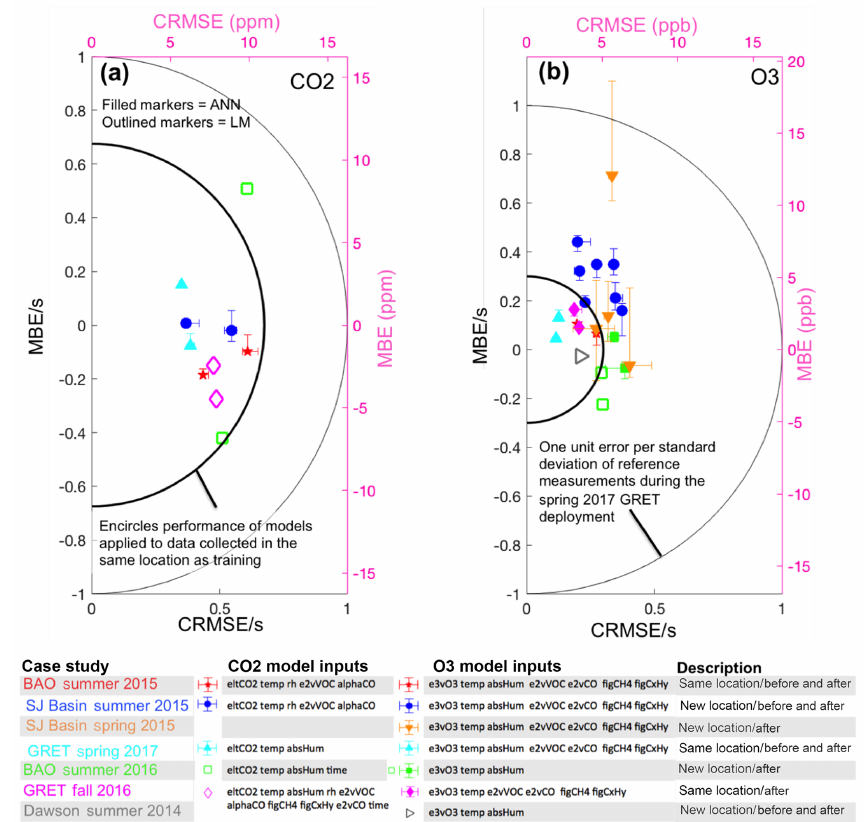
Figure 12. Target diagrams for (a) CO 2 and (b) O 3 calibration model performance for the best-performing model for each particular case when tested on data from a number of field deployments. Model input definitions: eltCO2 (ELT S-300 CO2 sensor), e2vCO (e2v MiCS-5525 sensor), e2vVOC (e2v MiCS-5521 sensor), e2vO3 (e2v MiCS-2611 sensor), figCH4 (Figaro TGS 2600 sensor), figCxHy (Figaro TGS 2602 sensor), alphaCO (Alphasense CO-B4 sensor), temp (temperature), absHum (absolute humidity), RH (relative humidity), and time (absolute